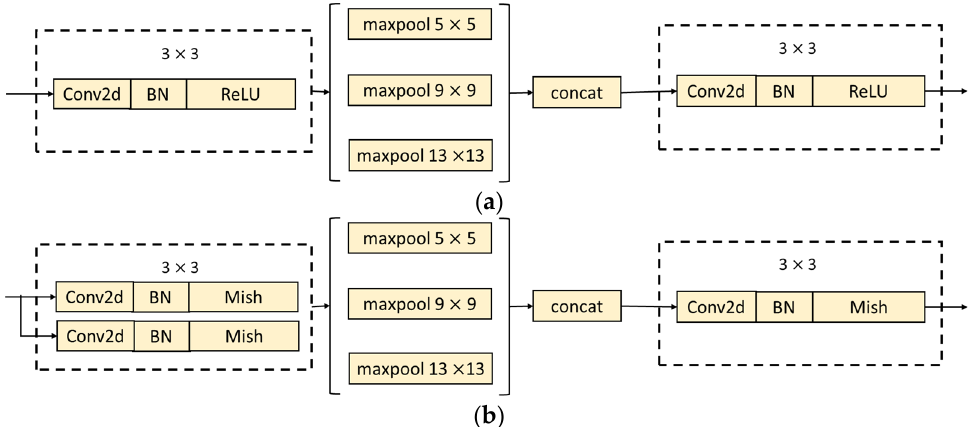
Figure 5. Neck network structure ( a ) Traditional YOLOv4 ( b ) our proposed FC-YOLOv4.